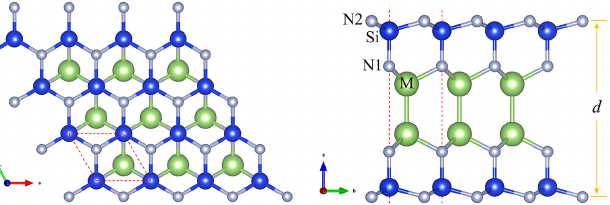
Figure 1. Top ( left panel) and side ( right panel) views of M 2 Si 2 N 4 (M = Al, Ga and In).